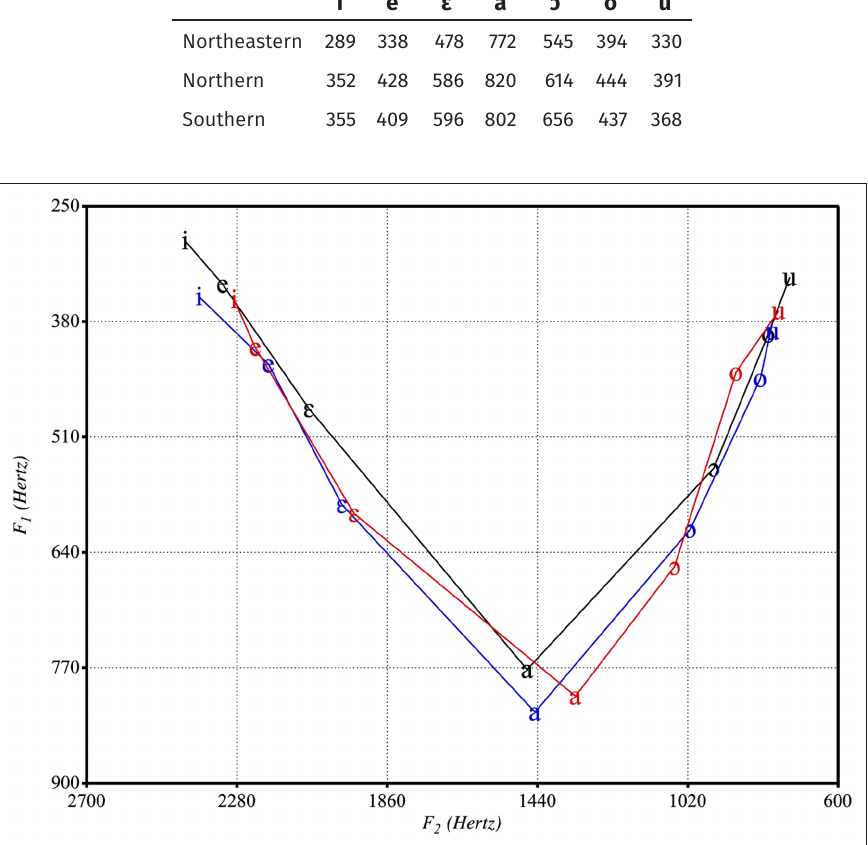
Figure 1: Mean of the first and second formant values of the 4182 stressed vowel tokens, grouped by dialect (black = NE-D, blue = N-D, red =